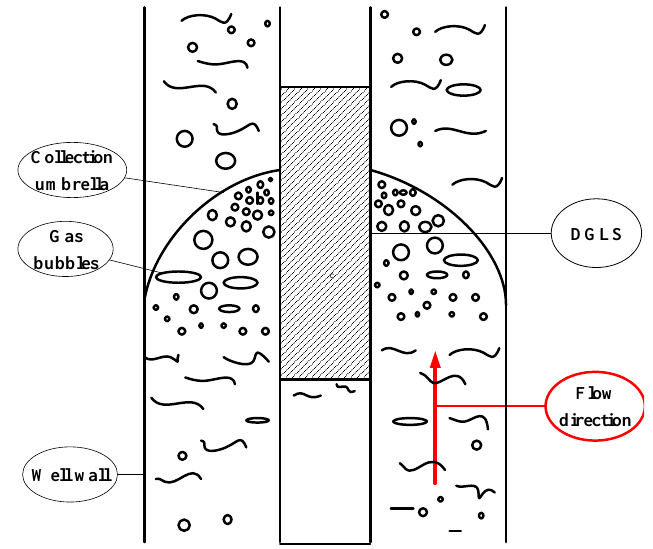
Figure 1. Schematic diagram of logging principle.